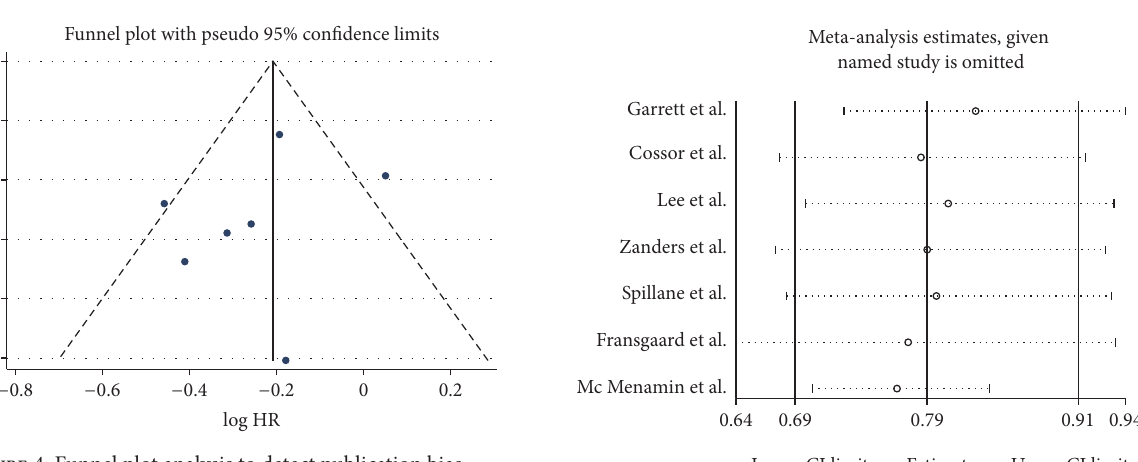
Figure 4: Funnel plot analysis to detect publication bias.